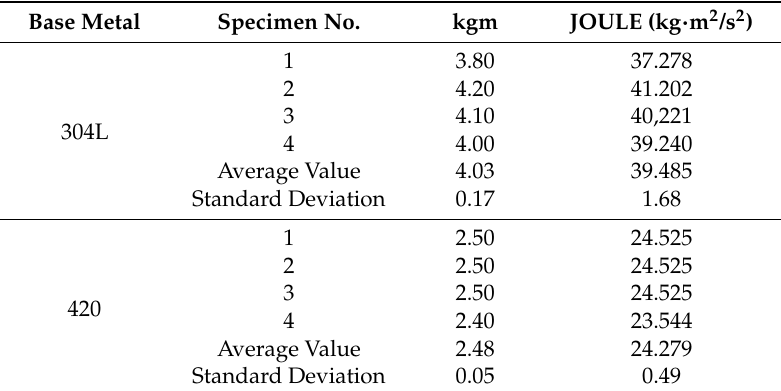
Table 5. Charpy impact energy values of base metal